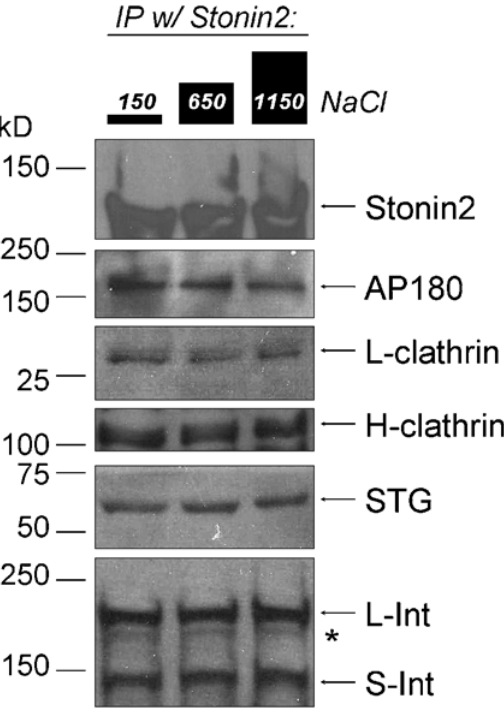
Figure 5. FR test of stonin2 as a complex component. Effect of high salt on recovery of proteins co-precipitated with stonin2. Legend as in Figure1C .